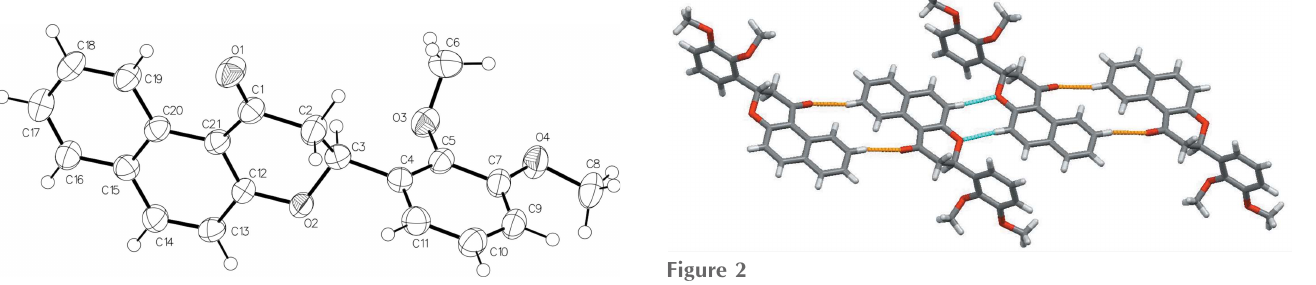
Figure 1 The molecular structure of the title compound, showing the atom- labelling scheme and displacement ellipsoids drawn at the 50% probability